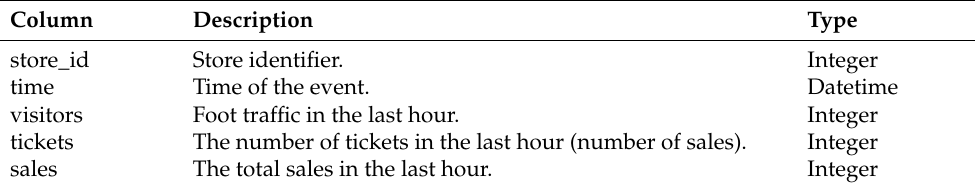
Table 1. Data obtained from Follow Up Application Programming Interface (API).